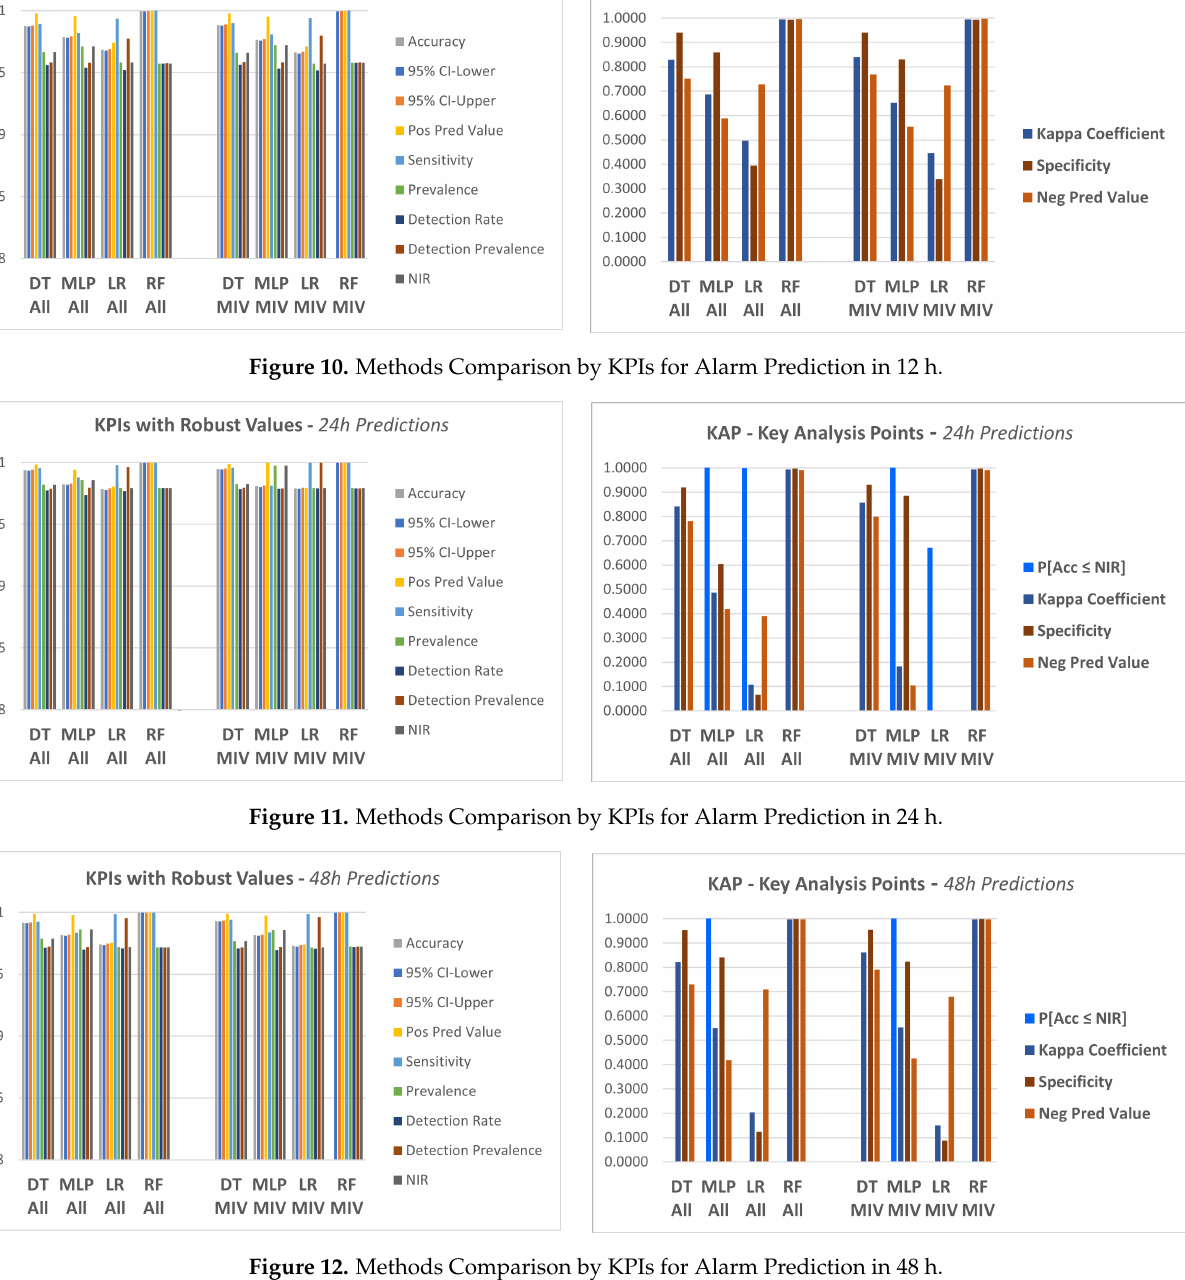
Figure 12. Methods Comparison by KPIs for Alarm Prediction in 48